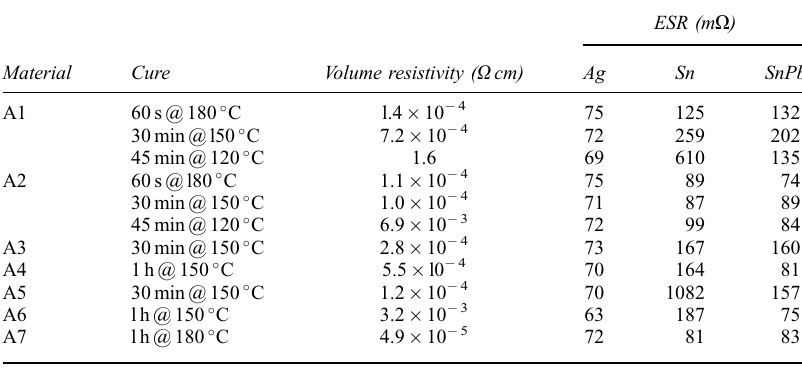
TABLE II Volume Resistivity and ESR Numbers on Different